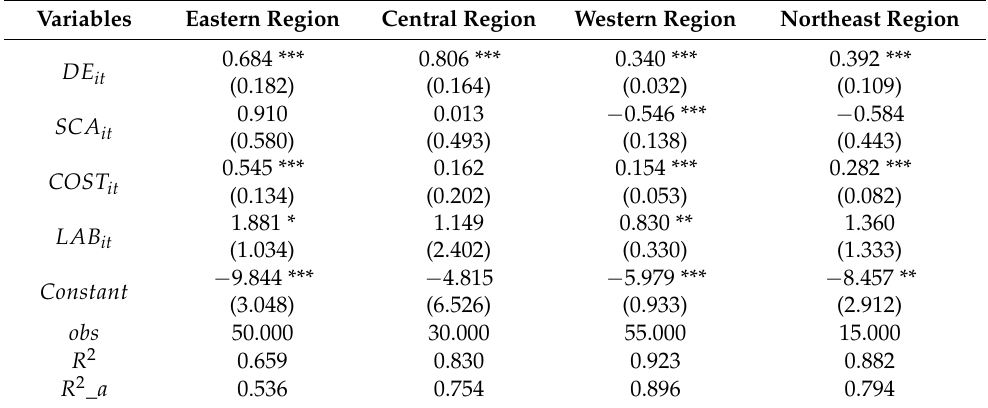
Table 9. Heterogeneity test result.